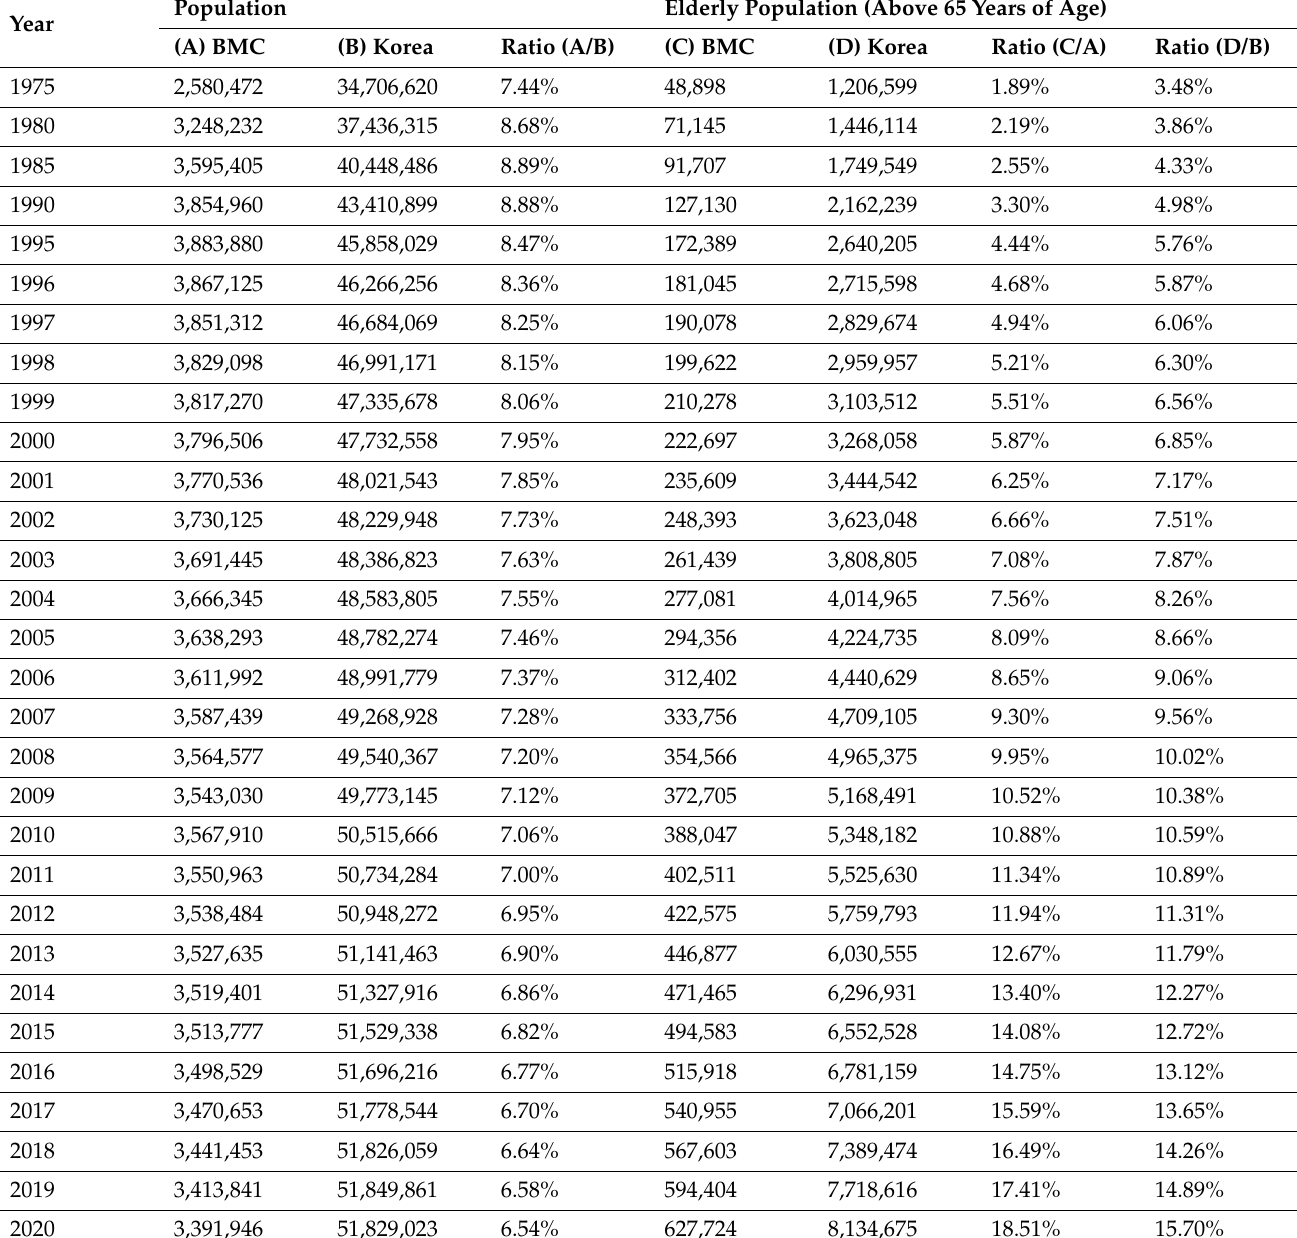
Table A1. Population in BMC and